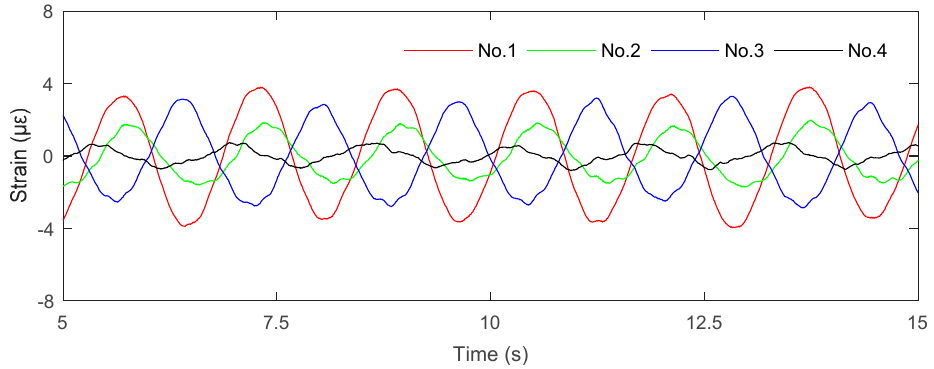
Figure 6. Time-series of the strain response of strain gauges at measurement position S5 in waves. Wave condition: H = 0.10 m and T = 1.6 s.